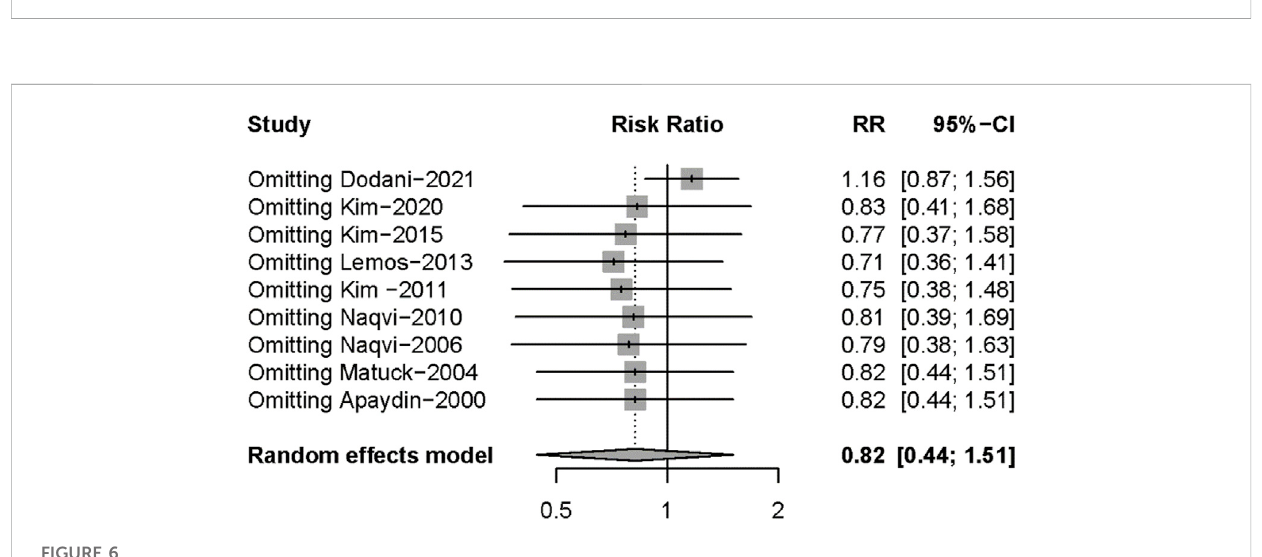
FIGURE 6 Sensitivity analyses for acute